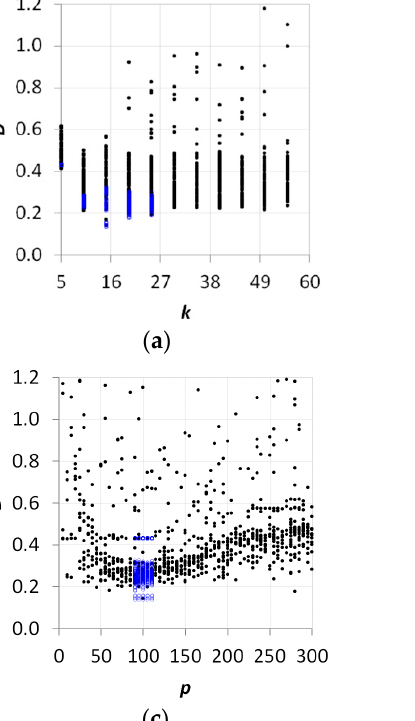
Figure 4. On the primary y-axis, the frequency of occurrence of D , f D , as the output of the segmentation calibration code (pilot areas representing arid and temperate periods in black and blue histograms, respectively). On the secondary y -axis, the cumulate of f D , F D , (dotted lines). The peak of the histogram representing the arid period, f D (black bars), is lower than